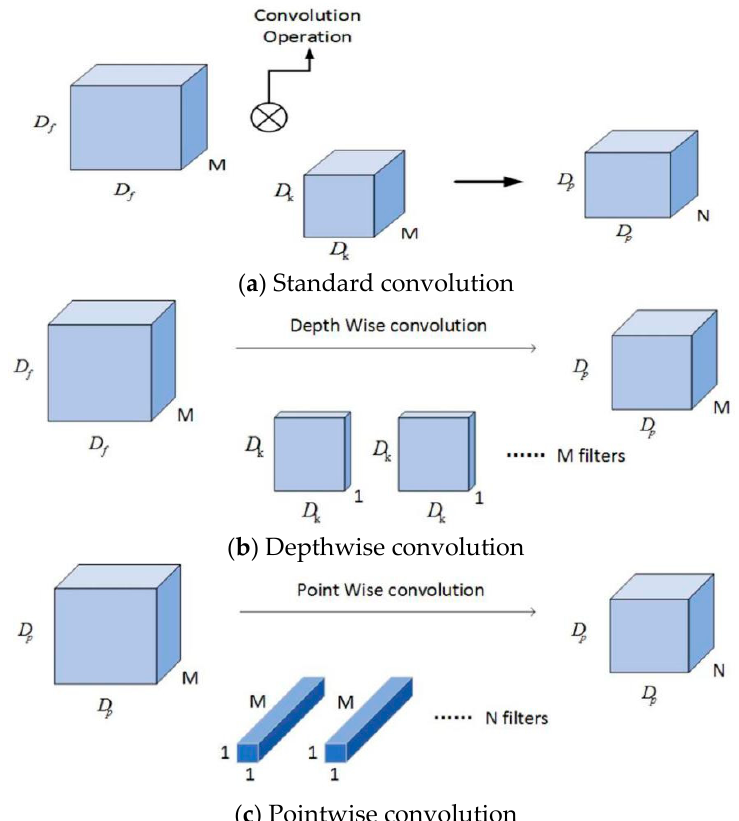
Figure 5. ( a ) The standard convolution is decomposed into ( b ) a depthwise convolution and ( c ) a 1 × 1 pointwise convolution.